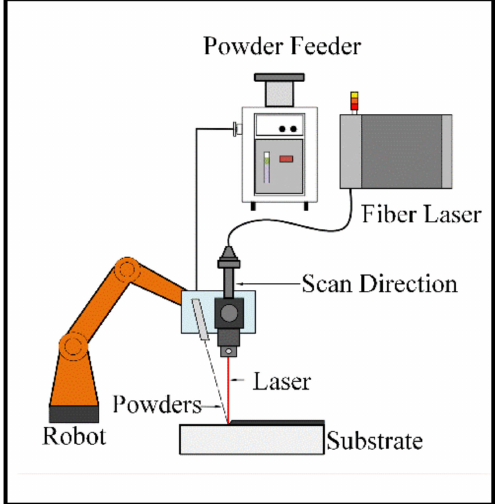
Figure 2. Equipment for the laser melt